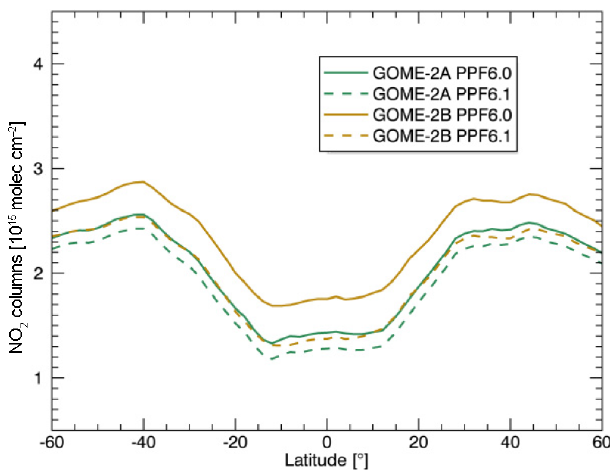
Figure 4. Monthly zonal average NO 2 columns (slant columns scaled by geometric AMFs) for GOME-2A (green) and GOME-2B (brown) using the new PPF 6.1 (dotted) and PPF 6.0 (solid) data in March 2015 over the Pacific (160–180 ◦ E).